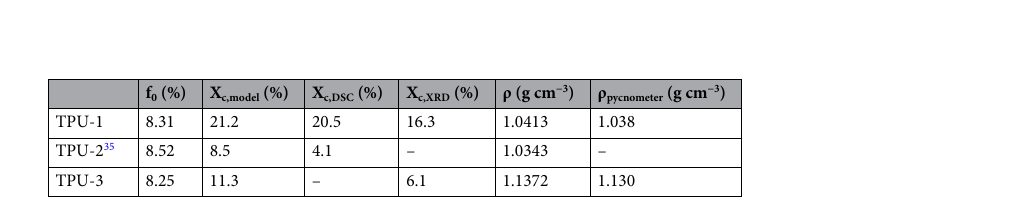
Table 7. The other parameters of the TPU samples used for